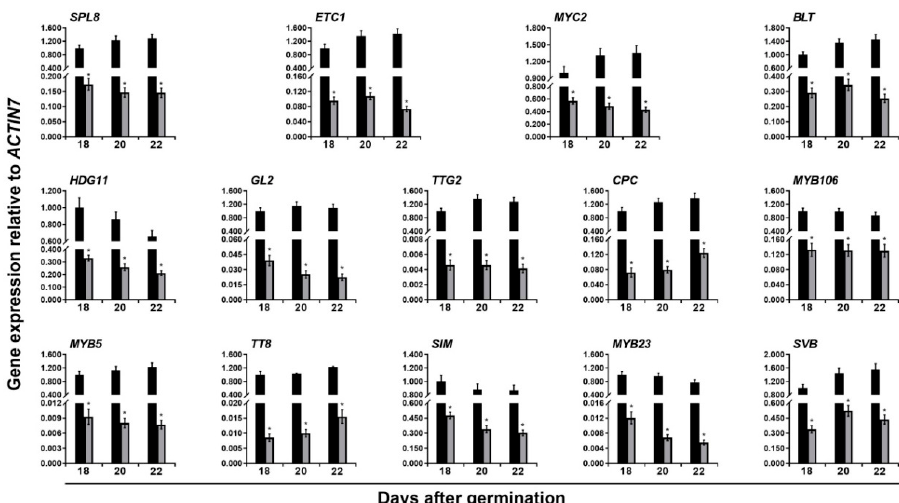
Figure 1. Dynamic expression analysis of differentially expressed genes involved in trichome formation in the young shoots and expanding true leaves between the wild type ( ) and ttg1-13 ( ) plants at 18, 20, and 22 days after germination. The house-keeping gene ACTIN7 was used as the internal control. The expression of each gene was first calculated relative to ACTIN7 and then normalized to its expression level at 18 days after germination in the wild type that was set to 1. Asterisks indicate significant differences in gene expression compared with the wild type control (two-tailed paired Student’s t test, p ≤ 0.05). Values are means ± SD ( n = 3). Error bars denote SD.